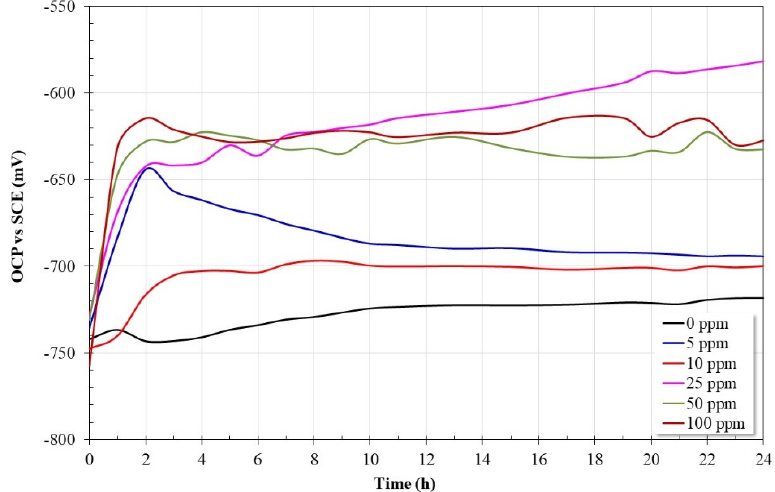
Figure 1. OCP variation for API-X52 steel in CO 2 -saturated brine at 60 °C, with and without inhibitor